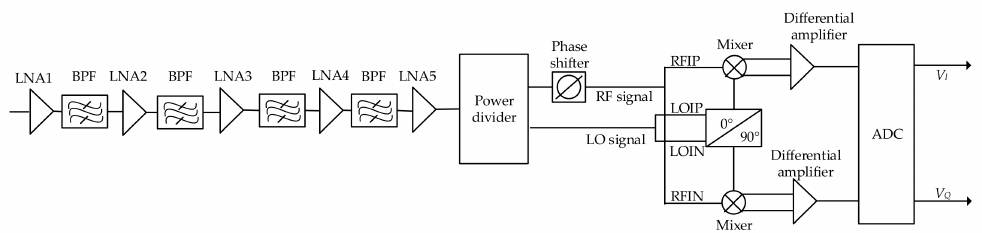
Figure 1. System block diagram of interferometric microwave radiometer. The signal amplified and filtered by multi-stage low noise amplifier enters the mi- crowave radiometer through the antenna, and then it is divided into two channel signals of equal amplitude and phase by the power divider. One of the radio frequency (RF) signals is mixing with local oscillator (LO) signal, the other RF signal is mixing with LO signal with 90 ◦ phase shift. After amplified by differential amplifier and sampled by ADC, the DC signal output from the correlation result represents the power value of the measured